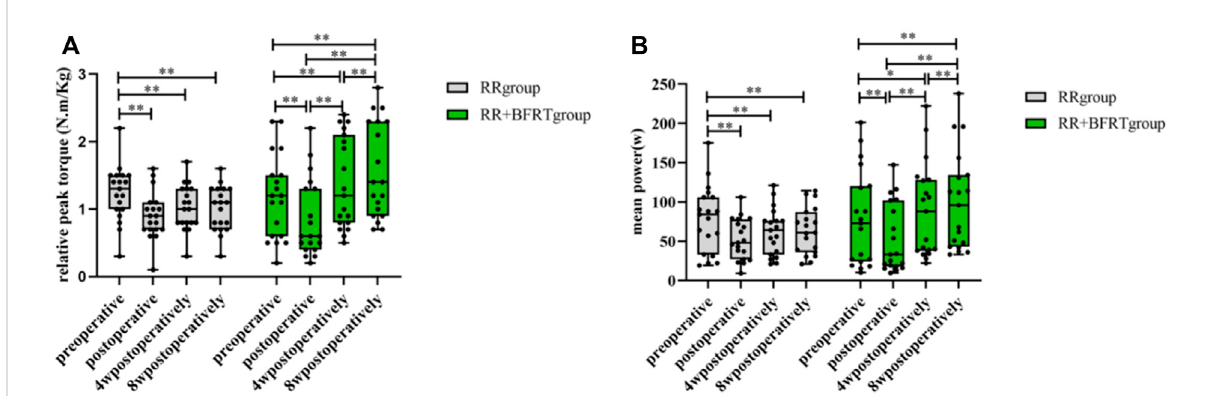
FIGURE 4 Intra-group comparisonofrelative peaktorque and meanpower in RRand RR+ BFRTgroups. “ ** ” indicatesa signi fi cantchange( p < 0.01). Values